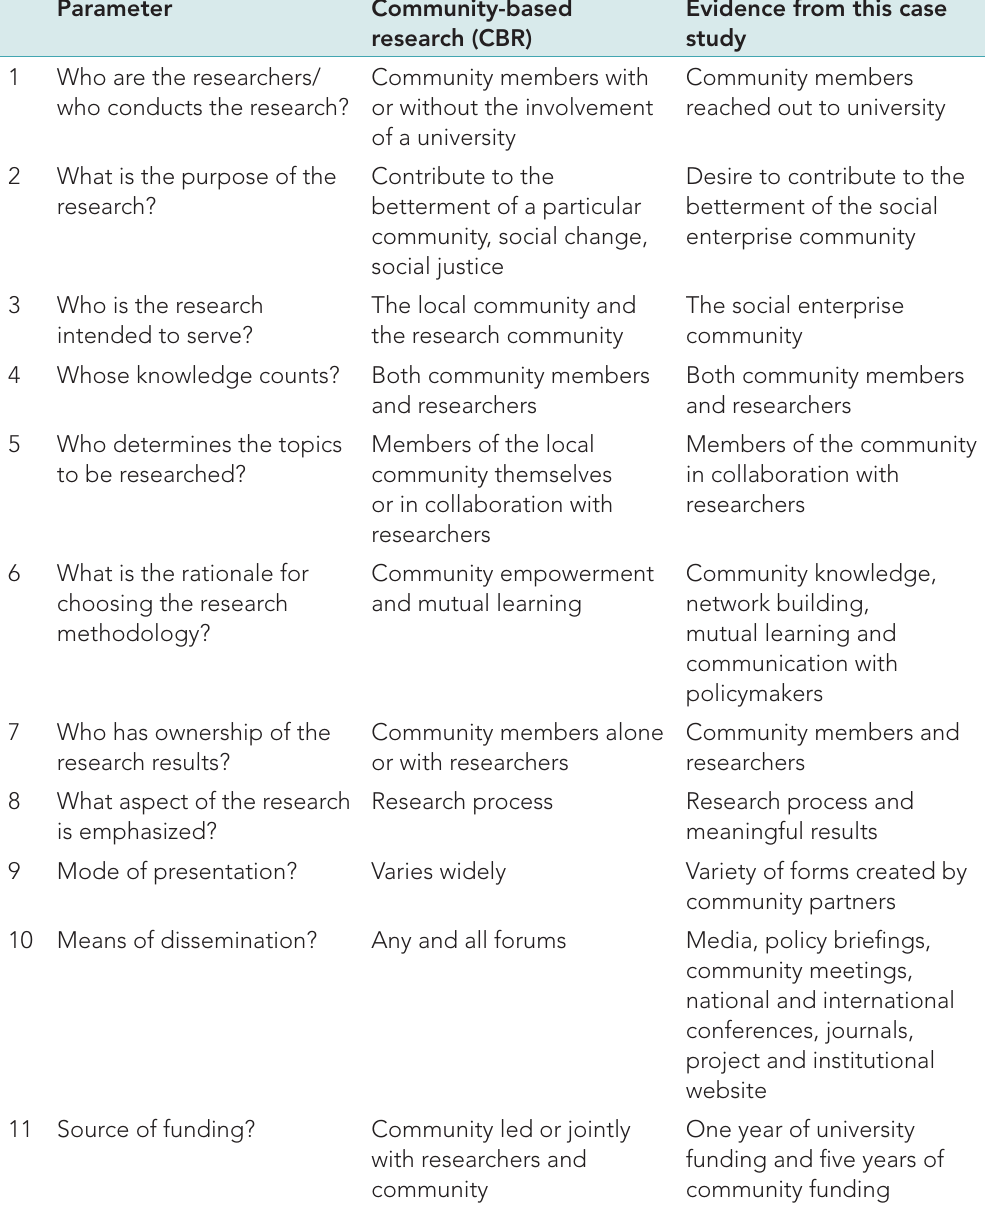
Table 4: Community-based research assessment criteria